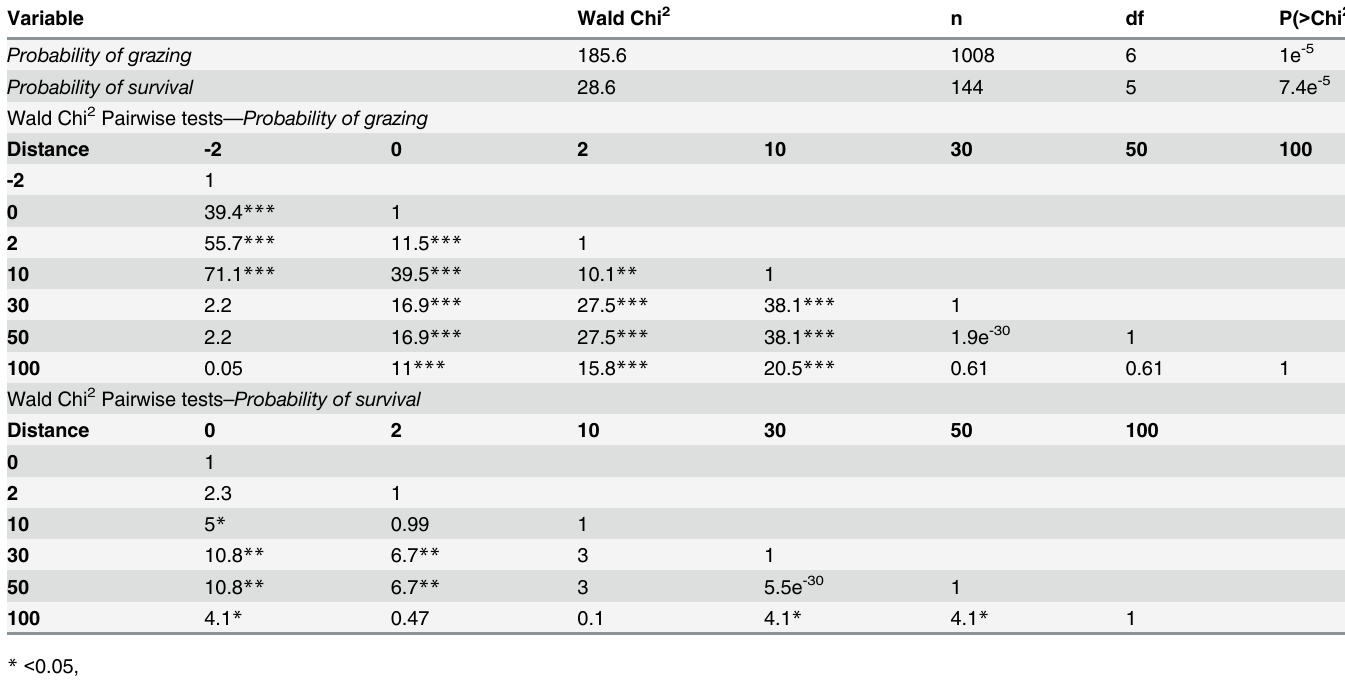
Table 1. Wald Chi square analysis (and Wald chi square pairwise comparisons) for predictive probability of daily grazing and predictive probability of survival six months after planting relative to distance from the seagrass edge. Variable Wald Chi 2 n df P( > Chi 2 ) Probability of grazing 185.6 1008 6 1e -5 Probability of survival 28.6 7.4e